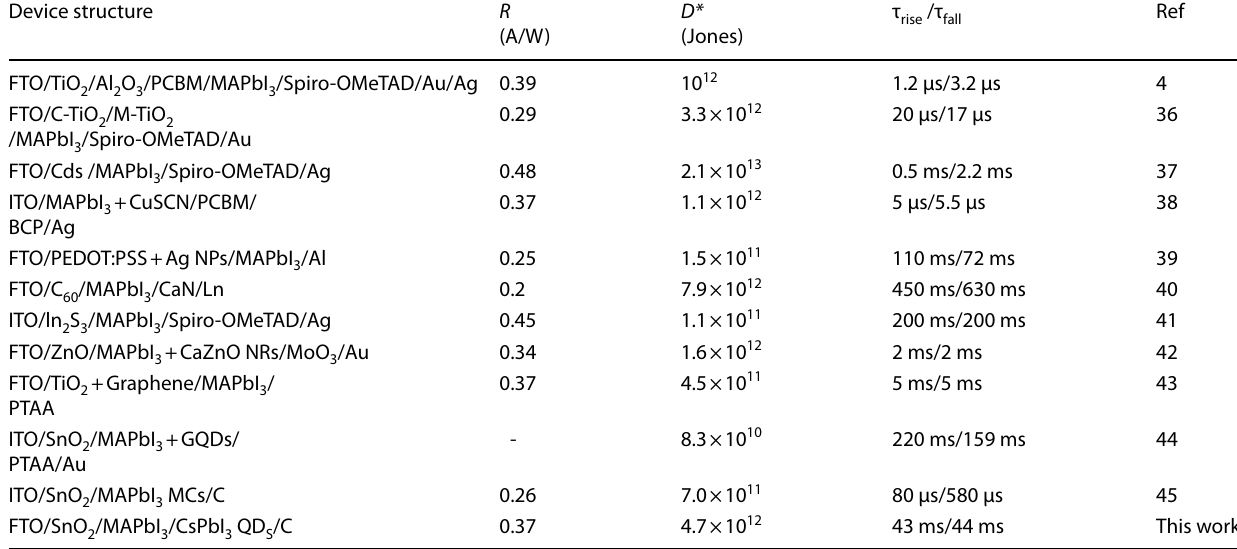
Table 2 Summary of performance parameters and device structure of PDs Device